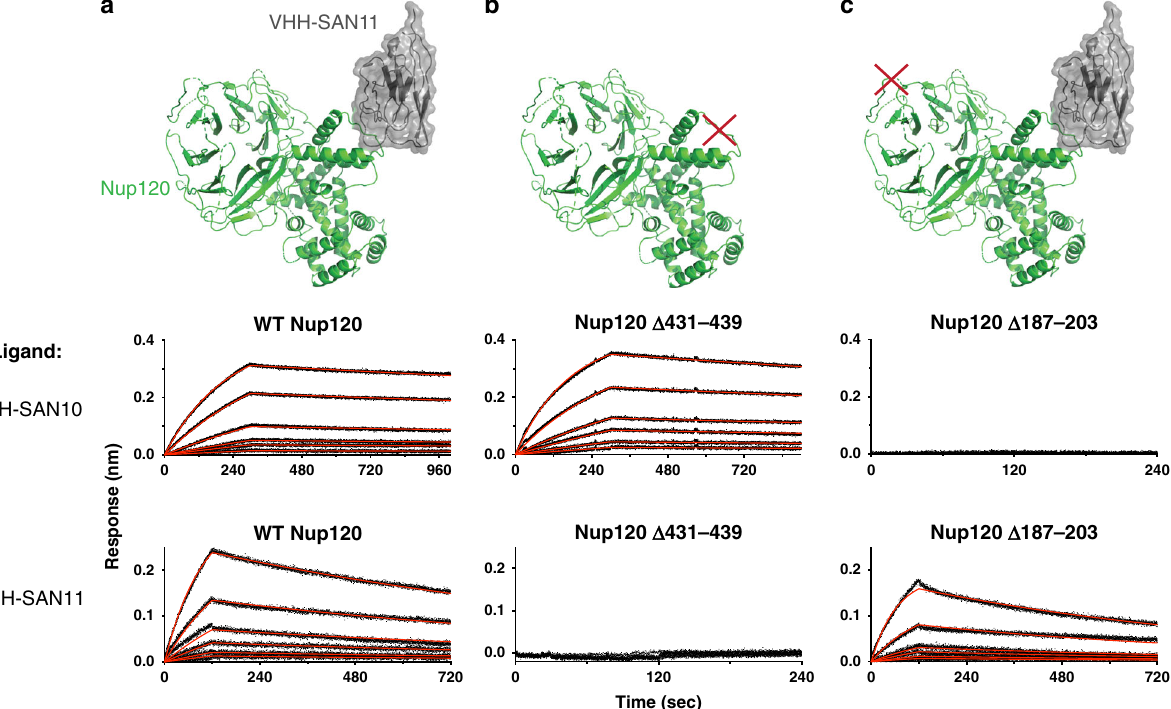
Fig. 4 Mutational analysis of Nup120 con fi rms the binding site of VHH-SAN10. Bio-layer interferometry (BLI) showing association and dissociation kinetics for VHH-SAN10 and VHH-SAN11 with Nup120 mutants. Nanobodies with a biotinylated C-terminal Avi-tag were fi xed (ligand) and nups used as analytes. Curves were corrected for buffer background. Each set of curves is a twofold dilution series from 10 nM analyte. Data are indicated by the black dotted lines and the red lines show the globally fi tted curves. a Structure of Nup120 1 – 757 -VHH-SAN11 and BLI data of wild type (WT) Nup120 1 – 757 as the analyte. b Illustration and BLI data of Nup120 1 – 757 Δ 431 – 439 (GSSx3) as the analyte. c Illustration and BLI data of Nup120 1 – 757 Δ 187 – 203 (GGSx5) as the